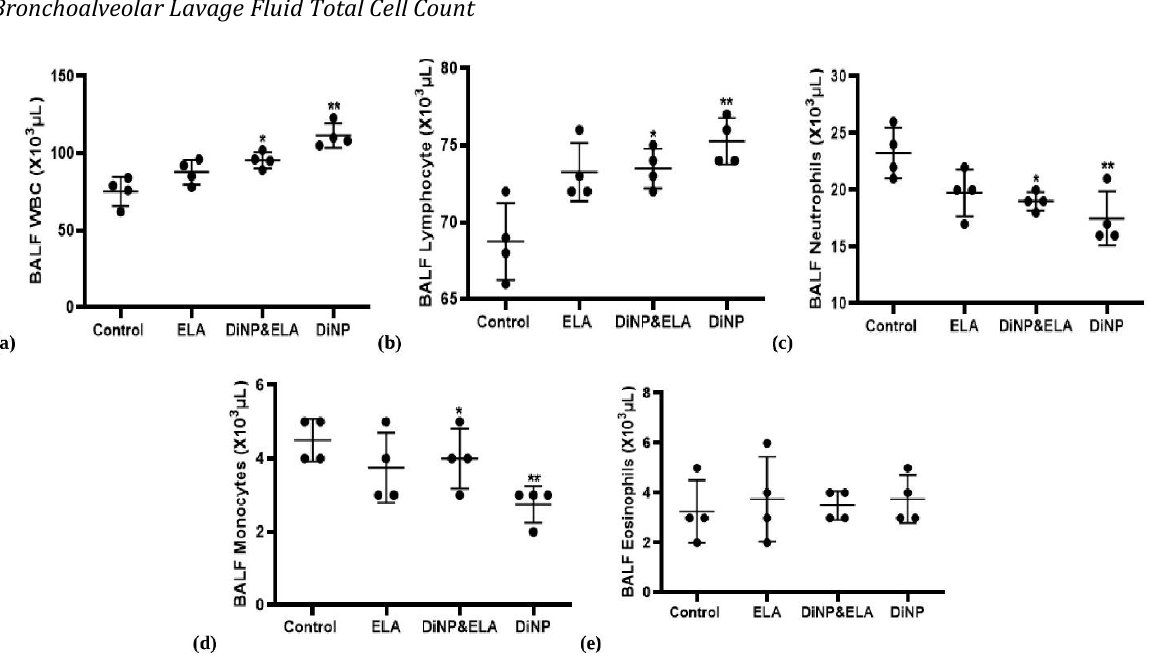
Bronchoalveolar Lavage Fluid Total Cell Count